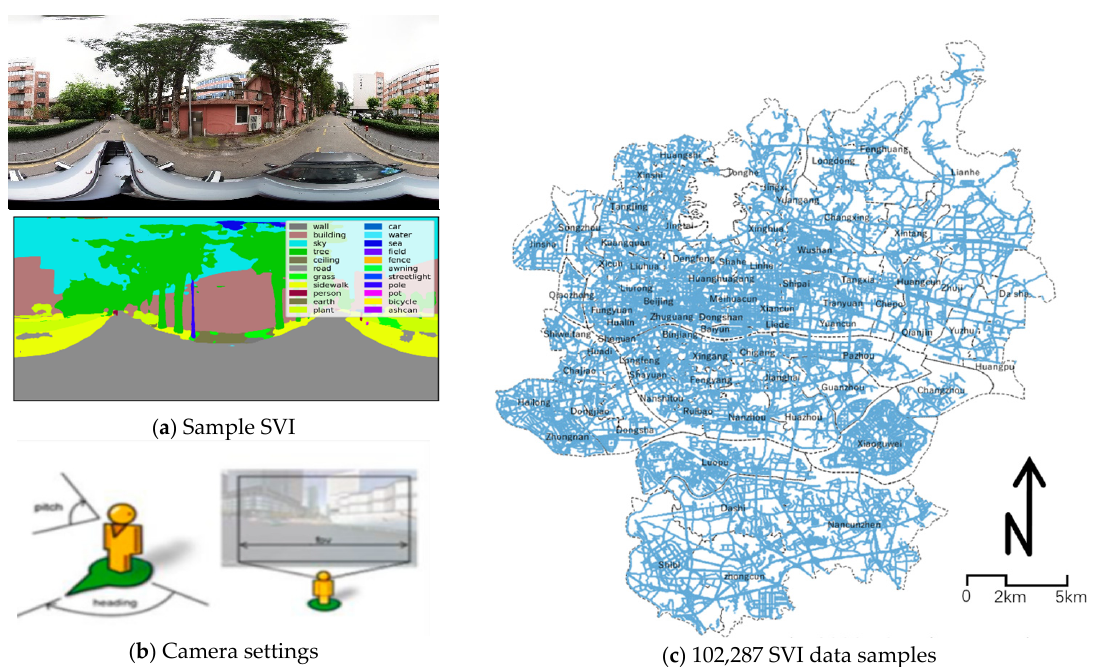
Figure 4. Sampling SVI and semantic segmentation ( a ) Sample SVI. ( b ) Camera settings diagram. ( c ) 102,287 SVI training samples. ( c ) 102,287 SVI training